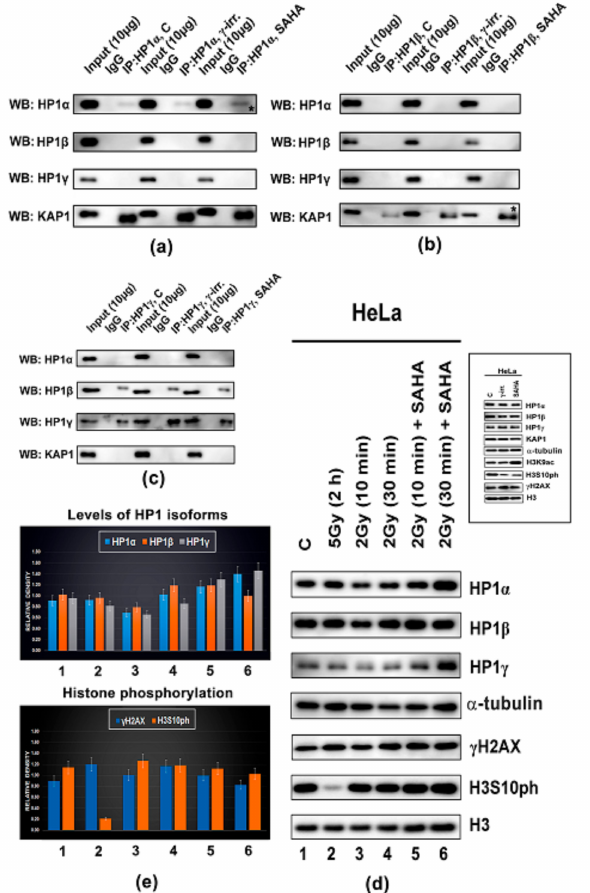
Figure 8. Immunoprecipitation analysis of potential interaction between HP1 α , HP1 β , and HP1 γ . Studies of following possible interactions: ( a ) HP1 α -HP1 α , HP1 α -HP1 β , HP1 α -HP1 γ ; HP1 α -KAP1; ( b ) HP1 β -HP1 α , HP1 β -HP1 β , HP1 β -HP1 γ ; HP1 β -KAP1; ( c ) HP1 γ -HP1 α , HP1 γ -HP1 β , HP1 γ -HP1 γ , HP1 γ -KAP1. Protein-protein interaction was studied in non-treated HeLa cells, and cells treated with SAHA (15 µ M) and irradiated by γ -rays (5 Gy). Cells were harvested for analysis 2 h the treatment. ( d ) Western blot analysis of following proteins: HP1 α , HP1 β , HP1 γ , KAP1, normalized to the total protein levels and α -tubulin, and H3K9ac, H3S10ph, γ H2AX, normalized to the level of total histone H3. ( e ) Data from large panel ( d ) were quantified by ImageJ software. Levels of HP1 isoforms were normalized to the level of α -tubulin, and γ H2AX or H3S10ph levels were normalized to the level of total histone H3. Profiles of HP1 α , HP1 β , HP1 γ , KAP1, H3S10ph, and γ H2AX were studied in (no. 1) non-irradiated HeLa cells, γ -irradiated Hela cells by (no. 2) 5 Gy of γ -rays / harvested after 2h; (no. 3) 2 Gy / harvested after 10 min; (no. 4) 2 Gy / harvested after 30 min; (no. 5) combination of SAHA treatment with 2 Gy / harvested after 10 min; and (no. 6) combination of SAHA treatment with 2 Gy / harvested after 30 min. A small panel in ( d ) is showing western blot data for non-treated HeLa cells, and cells irradiated by 5 Gy of γ -rays or SAHA (15 µ M) treated HeLa